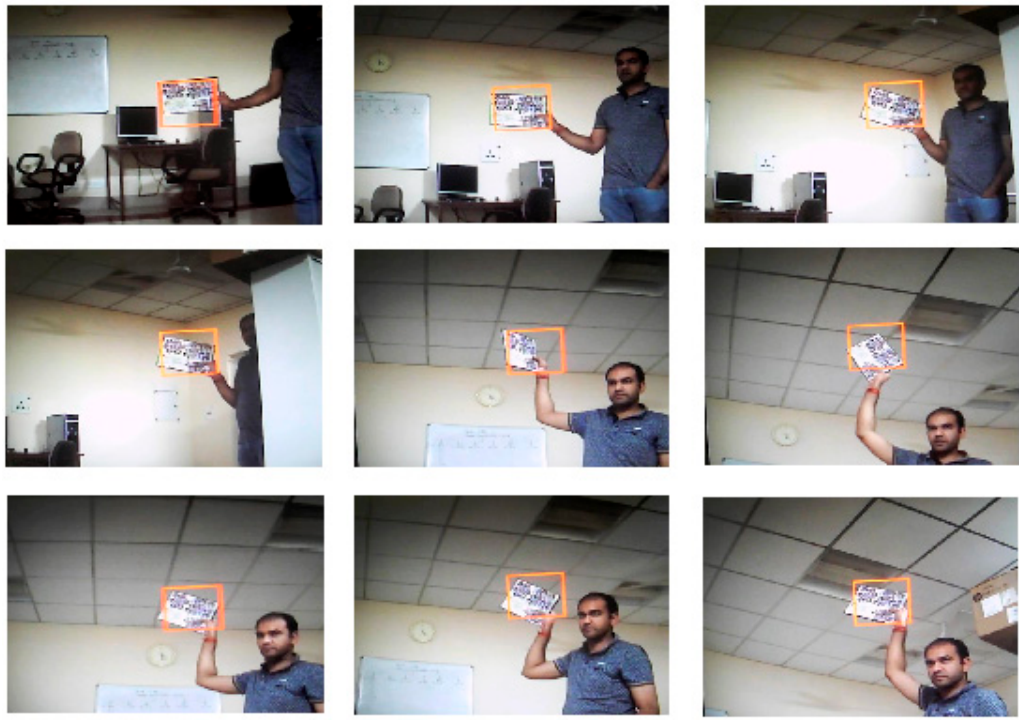
Figure 20. Frame sequence showing object tracking in scenes that change due to camera movement.